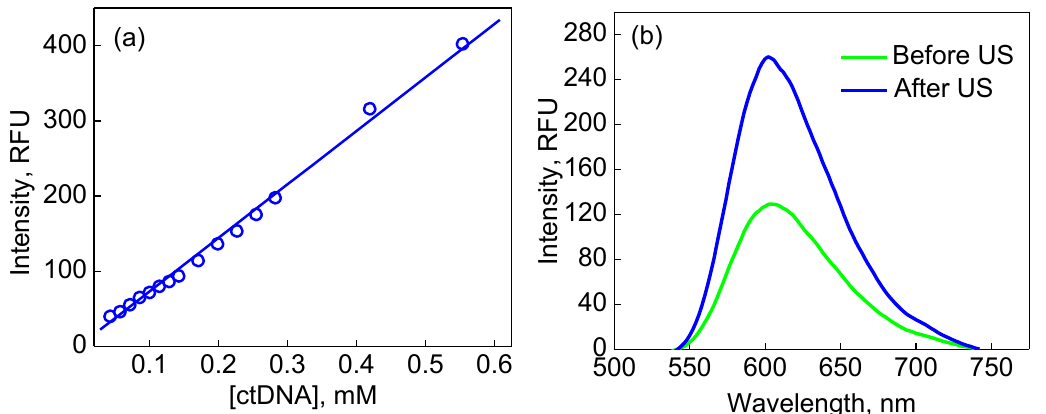
Figure 8. ( a ) dependence of fluorescence of dsDNA intercalated with EtBr on dsDNA concentration; ( b ) release of dsDNA from (PMAA/PVPON) 13 capsules after US-treatment with 22 kHz US (55 W/cm 2 for 20 s) as quantified with fluorescence microscopy.